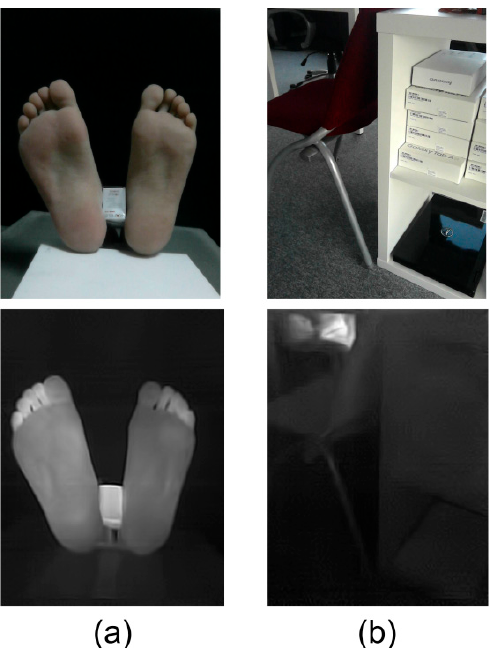
Figure 1. Sample images (optical images are above the thermal images): ( a ) Phantom Feet; ( b ) No Feet.